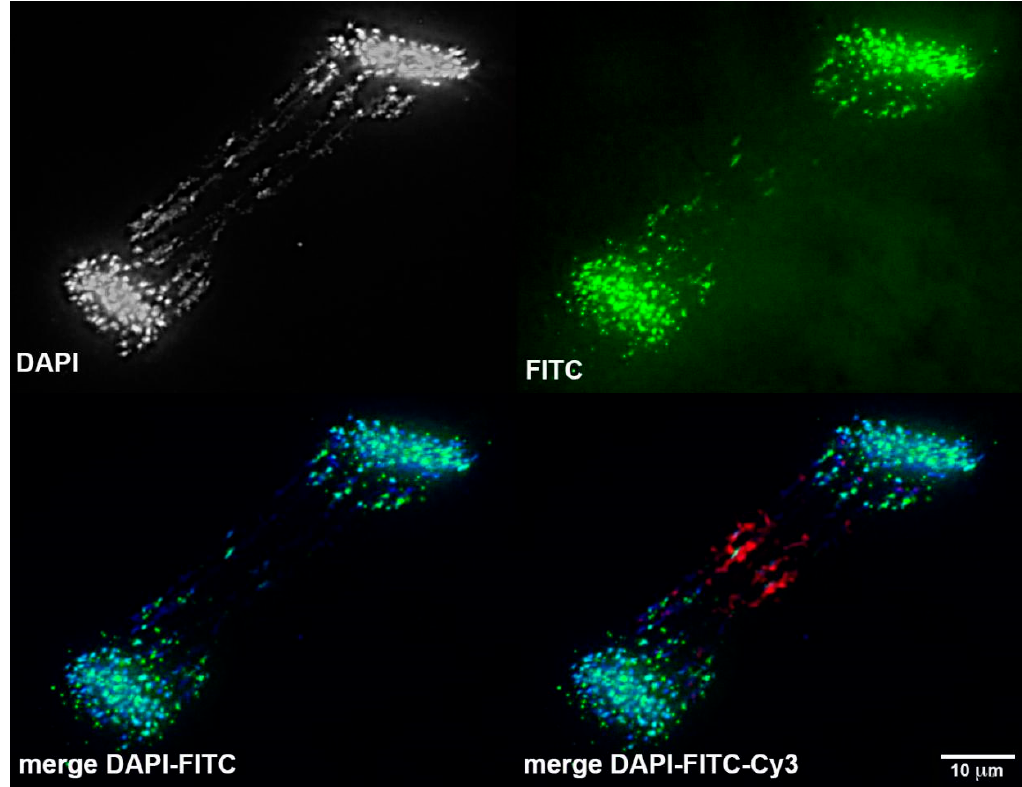
Figure 7. Telomeric contacts during chromosome elimination. Fluorescence in situ hybridization of telomere-specific (green) and Germ2 (red) to an anaphase from a 1.5 dpf embryo. See Figure S6 for additional examples.